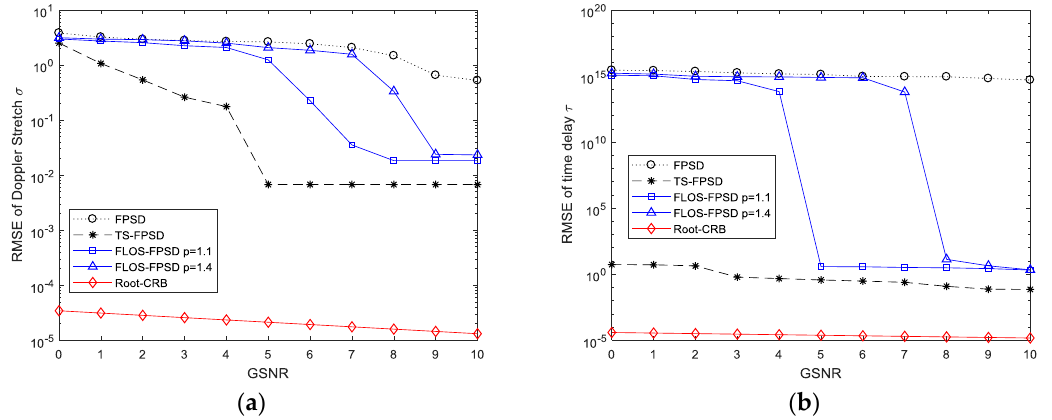
Figure 10. Estimation accuracy versus the generalized signal-noise-ratio (GSNR). ( a ) RMSE of the Doppler stretch; ( b ) RMSE of the time delay.